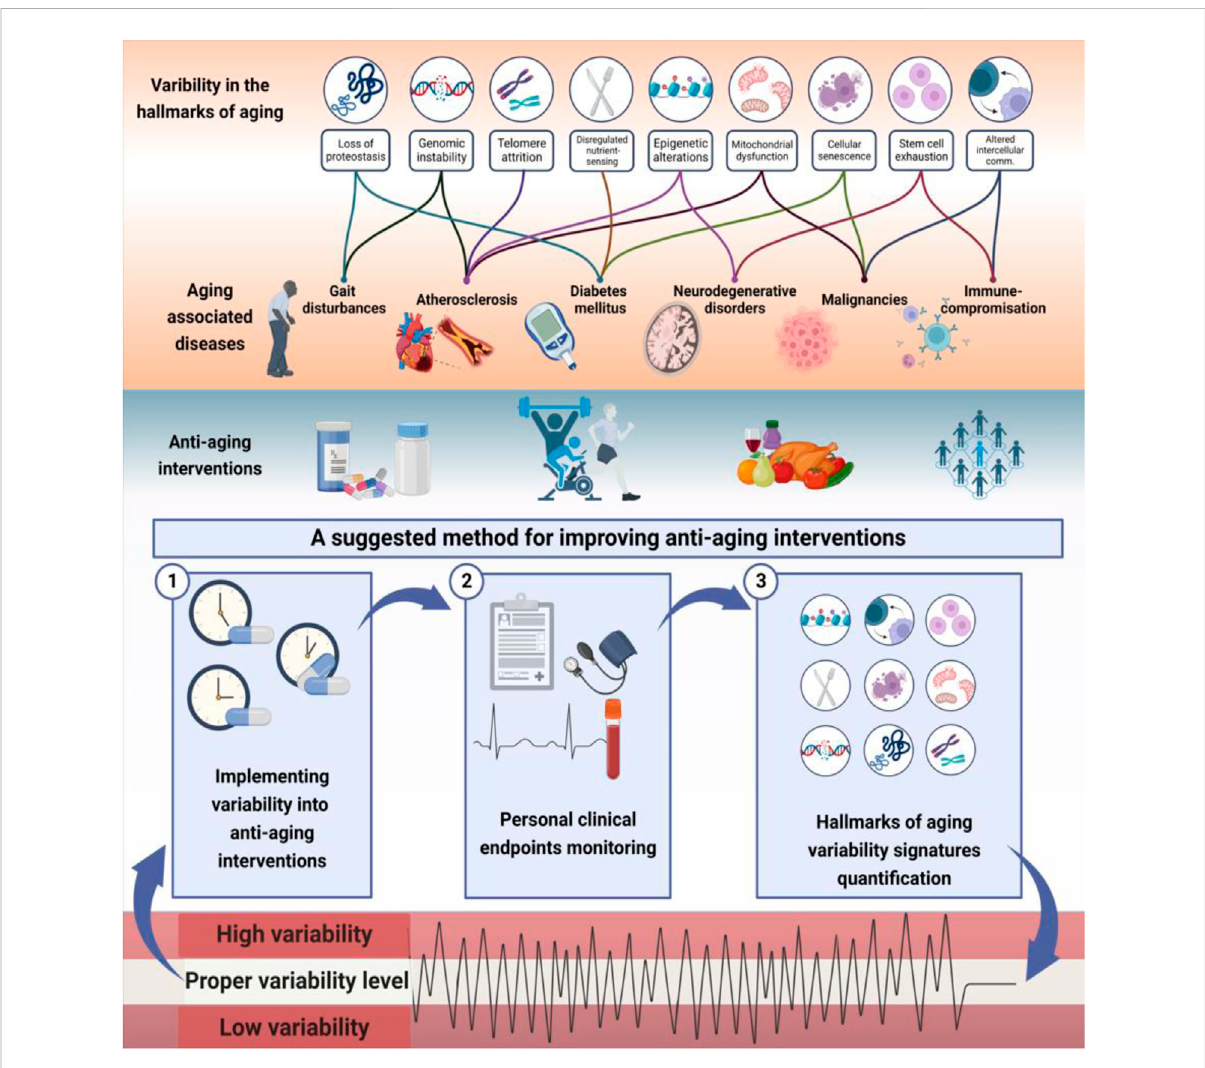
FIGURE 1 The hallmarks of aging are associated with altered variability and provide a basis for improving the effectiveness of anti-aging interventions: Illustrated is links between variability in hallmarks of aging and aging-related diseases. Higher or lower variability in molecular, intracellular, and intercellular mechanisms may result in accelerated aging. Per the constrained disorder principle, maintaining variability within a controlled range (in light green) may alleviate the aging process and improve anti-aging interventions. The system works in a three-stage process to implement variability into therapies within a determined range, track personal clinical endpoints, and dynamically modify the algorithm based on variability signatures. The potential of quantifying variability signatures of the hallmarks and implementing them into the algorithm is presented. The system enables enhancing internal variability when the degree of variability is too low or regulating the variability when it is too high (in red) to improve the effectiveness of anti-aging